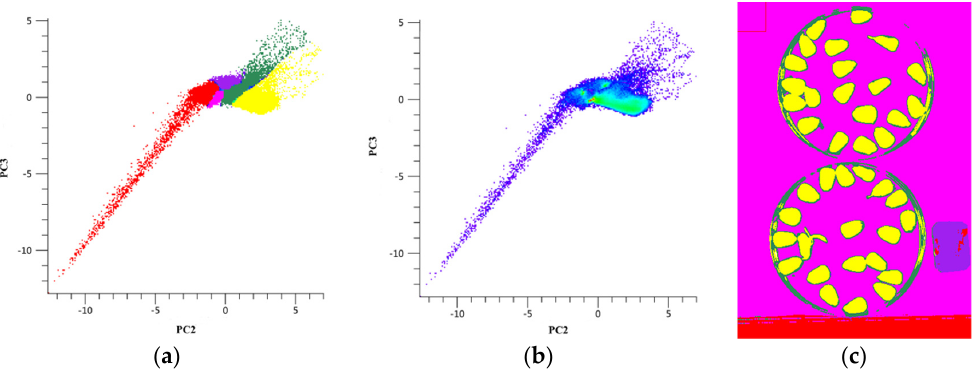
Figure 1. ( a ) PCA scatter plot of PC 2 vs. PC 3 (6.34% and 0.92%) of the image of D 7 ; ( b ) density scatter plot of PC 2 vs. PC 3 ; and ( c ) corresponding score image where the red class represented the whiteboard and lighting sections of labels, the magenta represented the background, the purple the label, sea green for most parts of the Petri dishes, and yellow for kernels and lesser parts of the Petri dishes.